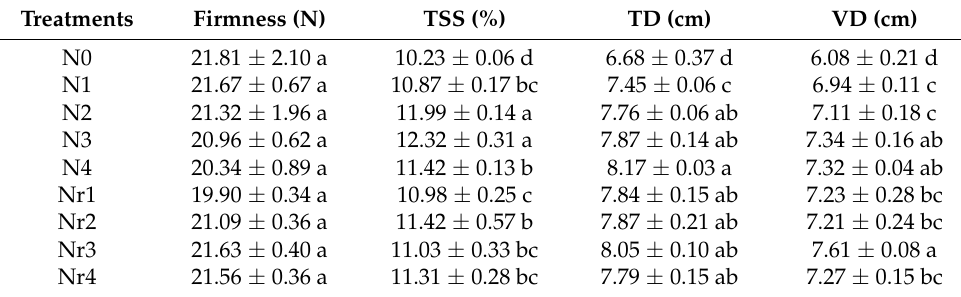
Table 7. Effects of different nitrogen application rates on fruit quality.